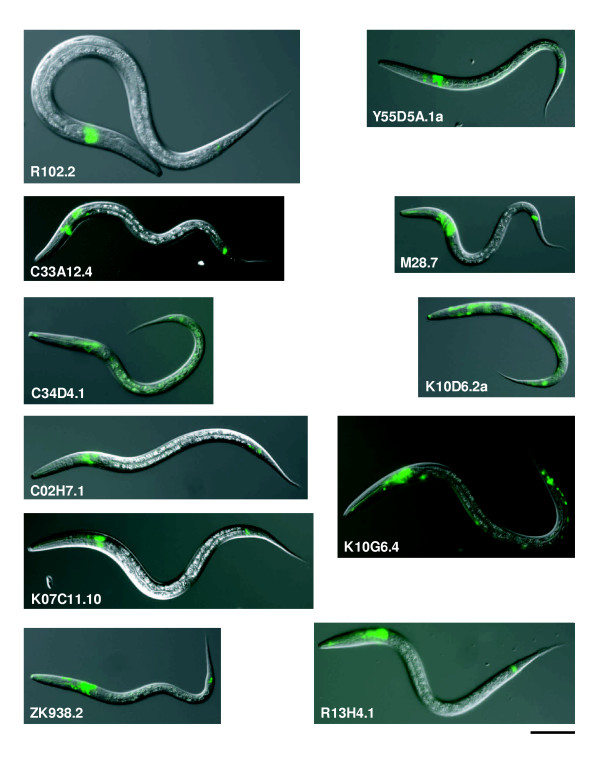
Expression patterns of newly identified sensory neuron-expressed genes. The genes indicated were each fused to GFP in-frame, and the reporters introduced into wild-type animals. Overlaid images of the Nomarski and GFP fluorescence images of transgenic worms between larval stages 1 and 3 are shown. Gene expression is indicated by the green fluorescence. Scale bar, 50 μm. See Table 1 for the identity of the expressing cells.